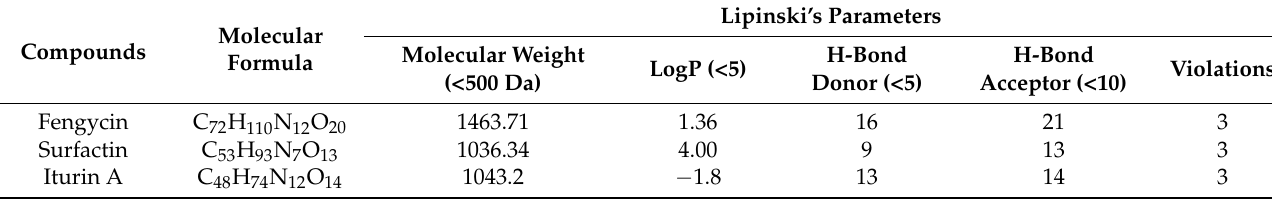
Table 7. Lipinski’s Ro5 analysis of fengycin, surfactin, and iturin